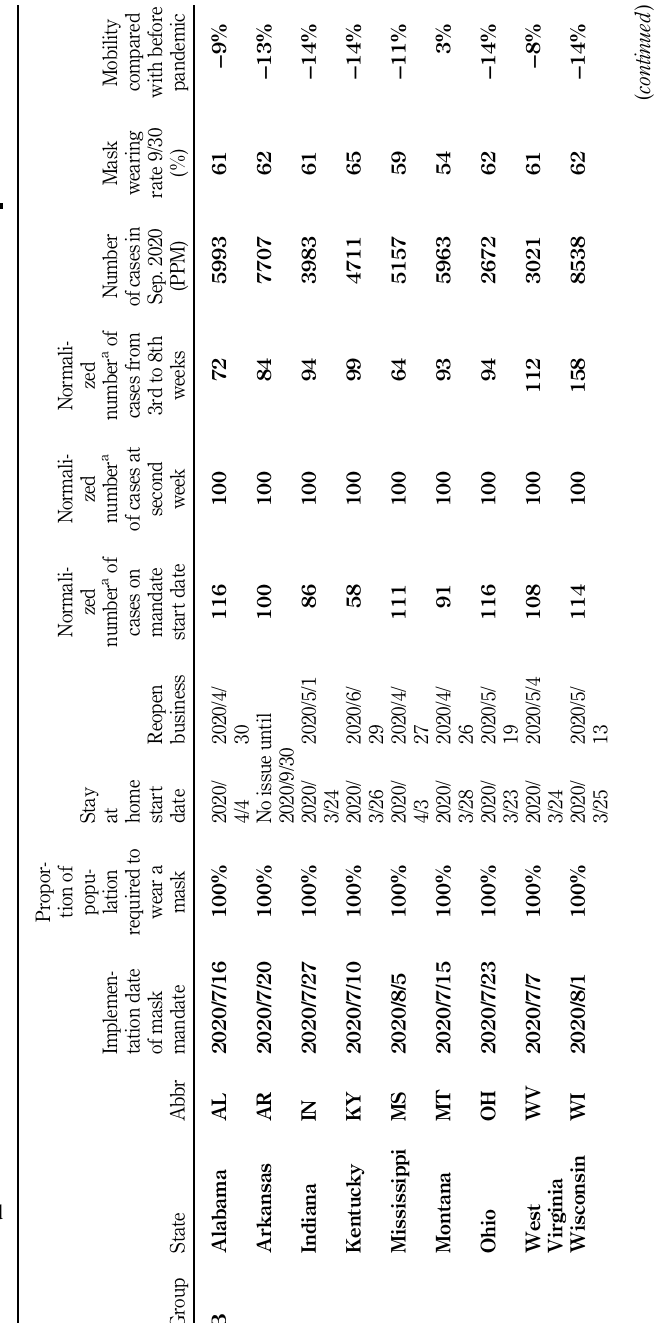
Table 1. Portion of dataset used for analyzing effect of mask wearing (Less than 15% mobility